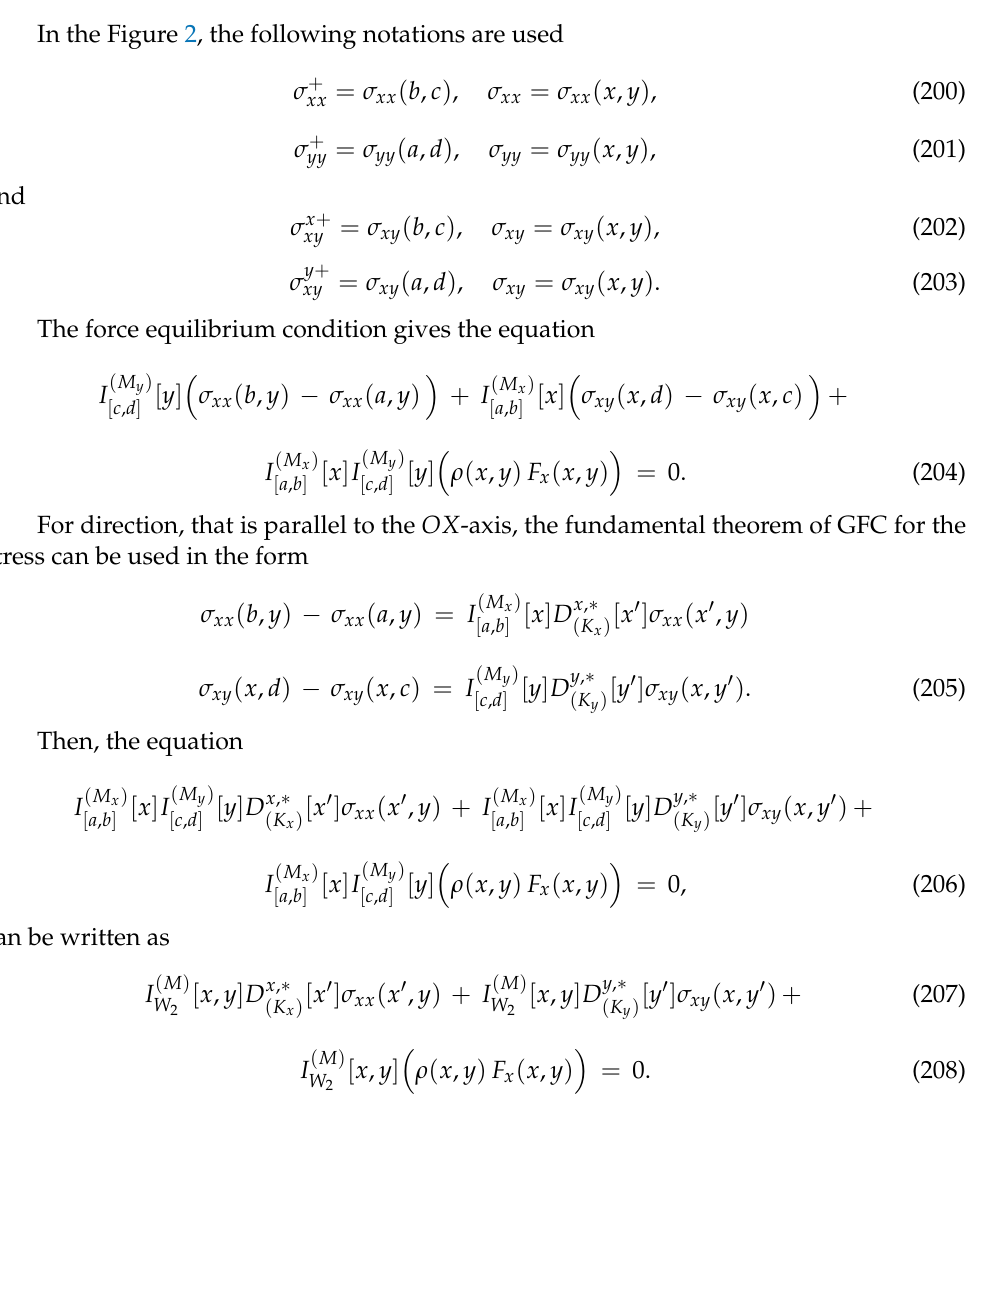
Figure 2: For stresses at time ∆ t in the XY -plane. Figure 2. For stresses at time ∆ t in the XY